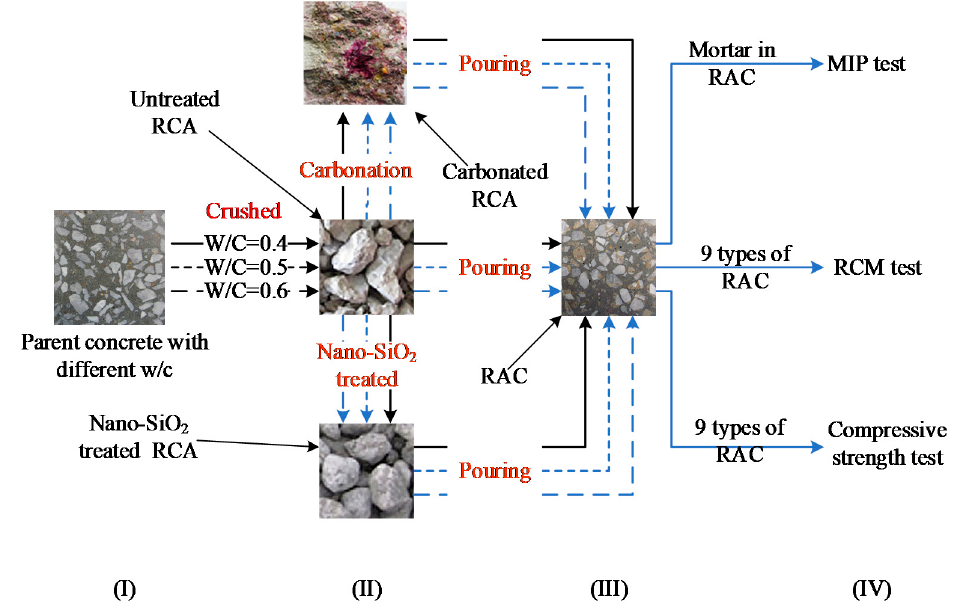
Figure 1. Flow diagram of the experiment.